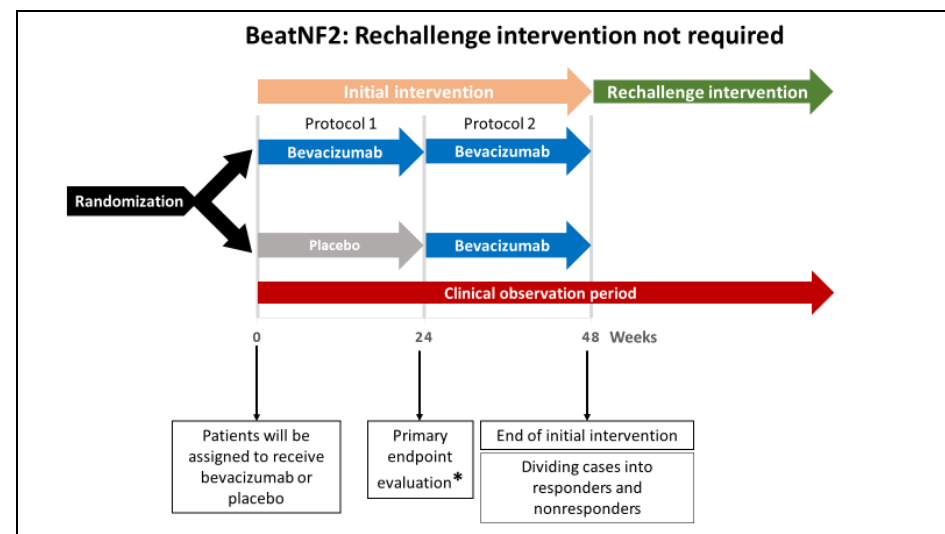
Figure 1. A schematic illustration of the BeatNF2 trial timeline.